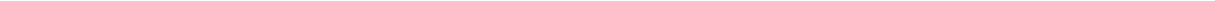
Fig. 5 Rab35 compartments form independently but require actomyosin and endocytic pathways for termination and polarity. a – c YFP:Rab35-labeled embryo injected with water control ( a ) or Y-27632 Rok inhibitor ( b ), during cell intercalation. Compartments form and resolve within 119 s in control embryo ( a ), whereas compartments form, but then fail to resolve, in Y-27632 embryo after 329 s ( b ). c Embryo 30 min post Y-27632 injection, showing elongation and bifurcation of Rab35 compartments. d Rab35 compartments form independently of F-actin function, but fail to terminate in LatB-injected embryos. Note compartment growth along plasma membrane. e Compartments grow into long, tubular structures and do not terminate in a YFP:Rab35 embryo injected with the endocytic inhibitor Pitstop2. f The number of Rab35 compartments per AP interface in water control, Y-27632, and chlorpromazine-injected embryos. Additional Rab35 compartments are present 1 and 2 min post-chlorpromazine injection. g Planar polarity of Rab35 compartments is compromised in Y-27632 and chlorpromazine-injected embryos, as opposed to water control. n = 133 (water), 156 (Y-27632), and 128 (chlorpromazine) compartments. h , i Rab35 compartments are contiguous with the cell surface. Rab35 compartments are labeled immediately when rhodamine-labeled dextran is injected extracellularly ( h ), before scissioning from plasma membrane ( i ) or shedding cytoplasmic dextran-labeled compartments (Supplementary Fig. 4f, g) in a YFP:Rab35 embryo. j Immunogold TEM images of anti-GFP CRISPR:GFP:Rab35 reveals Rab35 ( arrows ) is present in plasma membrane infoldings that are contiguous to the interface and present near adherens junctions ( white arrowhead ). k Quanti fi cation